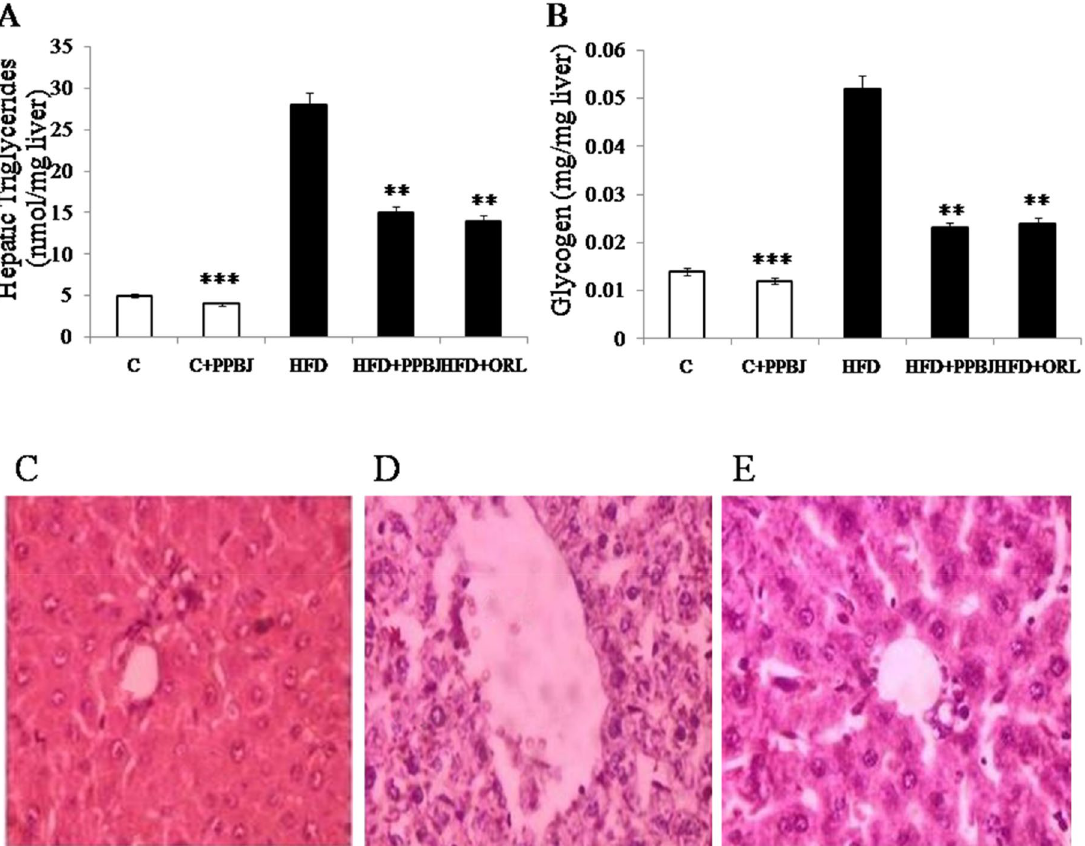
Figure 8. Effect of PPBJ on quantification of hepatic triglycerides, glycogen and, H & E staining for hepato steatosis. ( A ) Quantification of hepatic triglycerides. ( B ) Quantification of hepatic glycogen. ( C ) Control liver. ( D ) HFD obese liver (hepato steatosis) and ( E ) HFD treated with PPBJ liver. PPBJ pectinase treated probiotic banana juice; HFD high fat diet; ORL Orlistat. H & E hematoxylin and eosin staining. Data was presented as mean ± SEM (n = 6 each group). Statistically significance compared to their respective controls ***p < 0.001; **p < 0.01; *p < 0.05 . Groups compared using one way